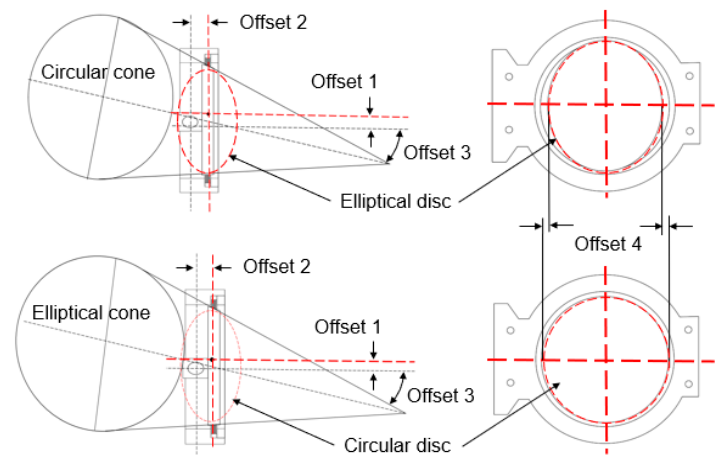
Figure 3. Offsets of TOBV and Figure 3. O ff sets of TOBV and QOBV.